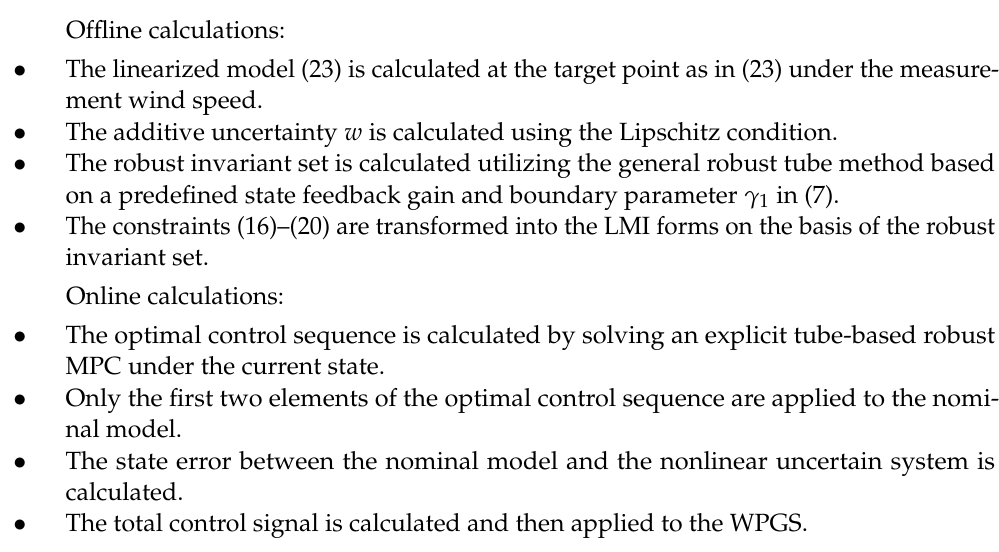
Figure 2. Robust MPC scheme for